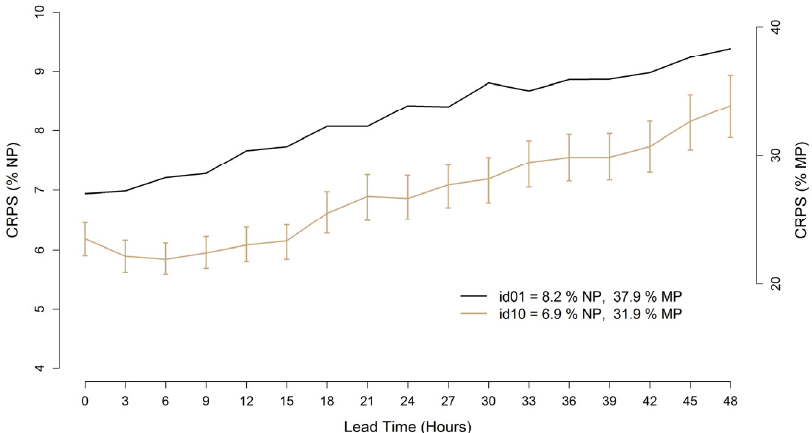
Figure 12. Error trends of the 0–72 h ahead probabilistic wind power forecasts starting at 0, 6, 12 and 18 UTC for the Klim test case ( CRPS / NP % and CRPS / MP